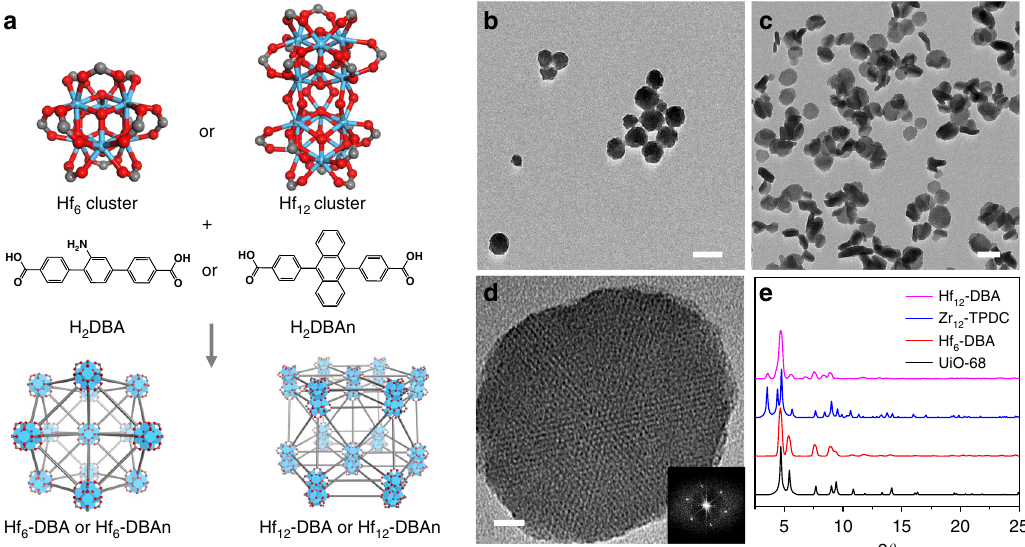
Fig. 1 Structures and morphologies of Hf 6 -DBA and Hf 12 -DBA. a Synthesis of Hf 6 -DBA, Hf 6 -DBAn, Hf 12 -DBA, and Hf 12 -DBAn. Transmission electron microscopy (TEM) images of Hf 6 -DBA ( b ) and Hf 12 -DBA ( c , d ) with its fast Fourier transform (FFT) pattern shown in the inset of d . Scale bar = 100 nm ( b , c ) or 10 nm ( d ). e PXRD patterns of Hf 6 -DBA and Hf 12 -DBA nMOFs in comparison to those of UiO-68 and Zr 12 -TPDC. For TEM images, each nMOF